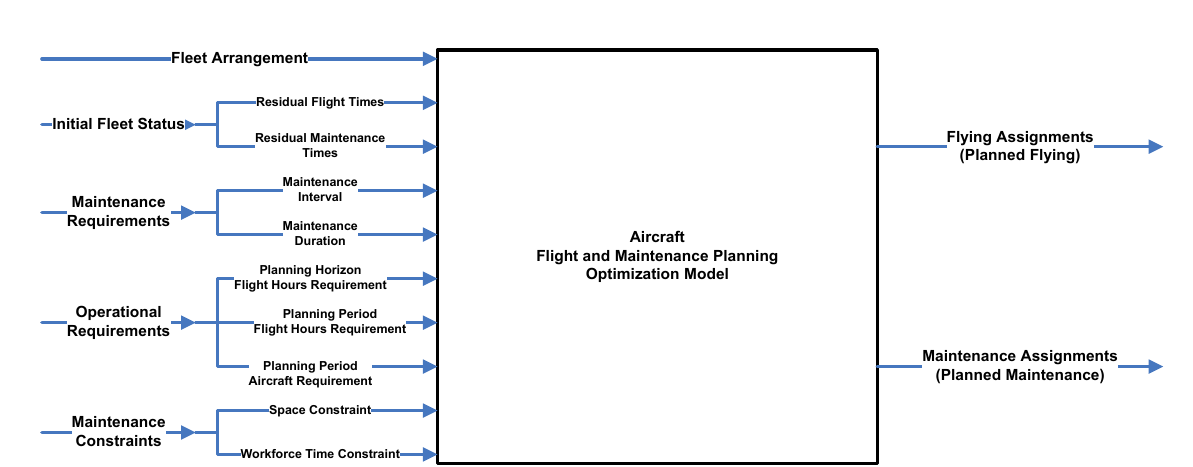
Figure 2. Schematic representation of the aircraft flight and maintenance planning optimization framework, showing the required in- and